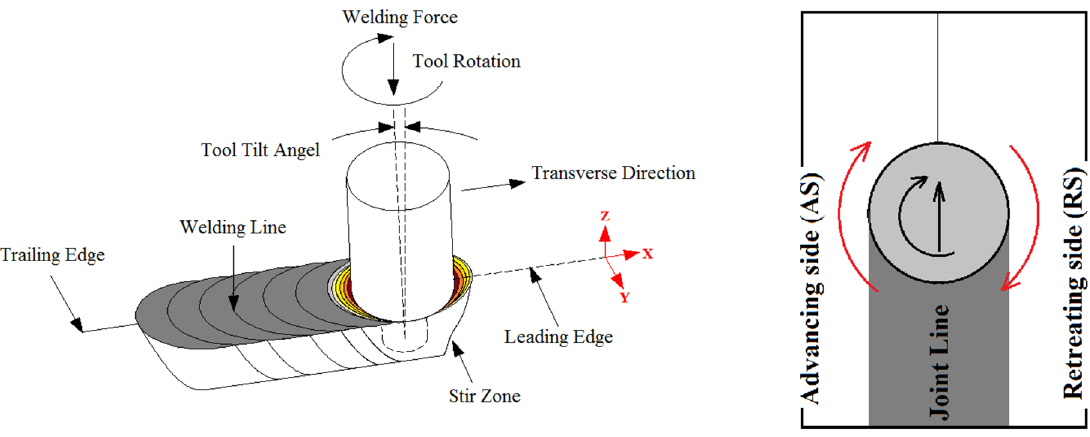
Figure 6. Linear friction stir welding illustration and different parts name [20].